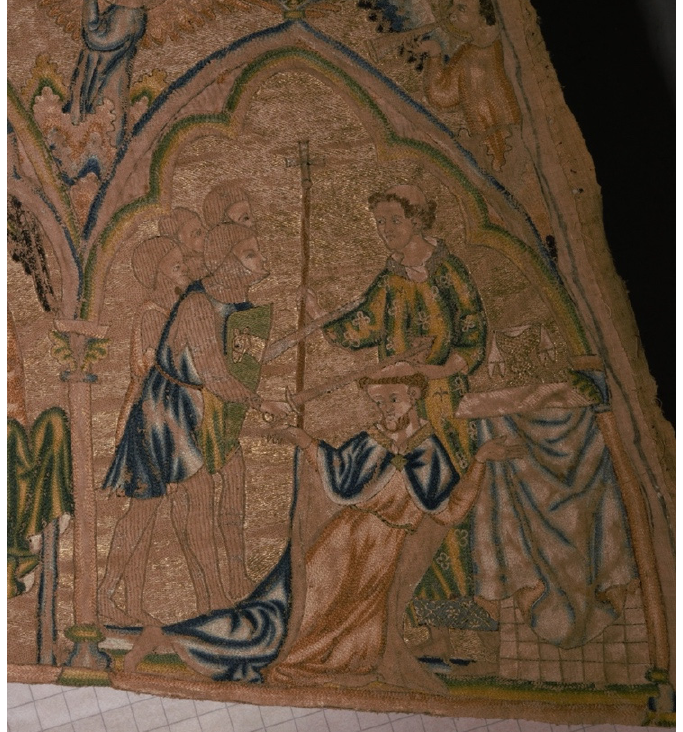
Figure 18. Bologna cope, detail: Thomas Becket’s murder. Bologna, Musei Civici d’Arte Antica, Italy. © Musei Civici d’Arte Antica di Bologna.